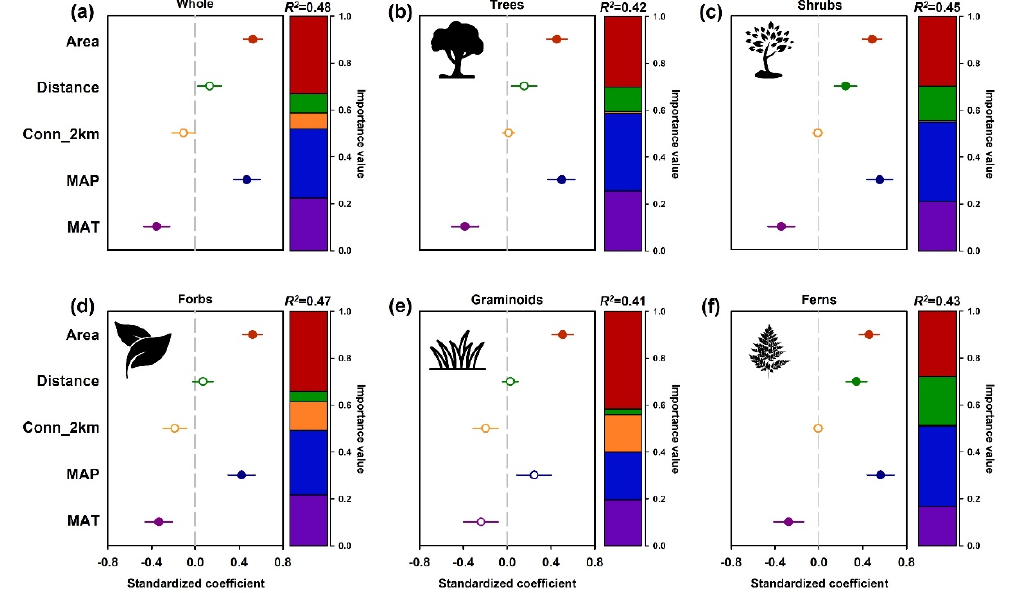
Figure 6. Standardized parameter estimates represent the effects size (circle) and standard error (bar) of five environmental factors for ( a ) whole, ( b ) trees, ( c ) shrubs, ( d ) forbs, ( e ) graminoids (sedges, grades, and rushes), and ( f ) ferns species richness on inhabited islands, South Korea. The closed and open circles indicate significant and non-significant relationships between species richness and environmental factors, respectively. The relative importance of each factor was calculated as the ratio between the parameter estimate of the factor and the sum of all parameter estimates and then described as a percentage. In the left and right subgraphs of a graph, the same color represents the same variable. Abbreviations for the factors are shown in Figure 3.